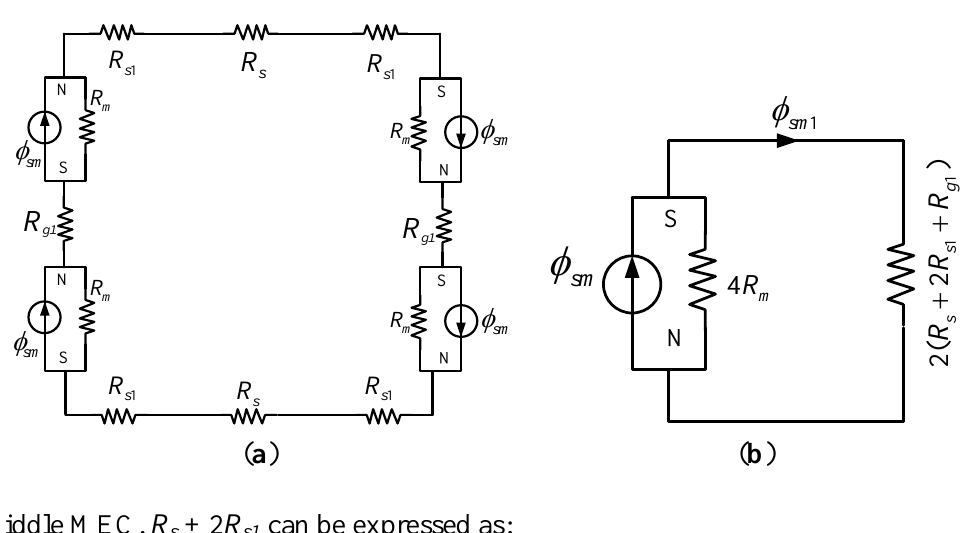
Figure 7. The middle